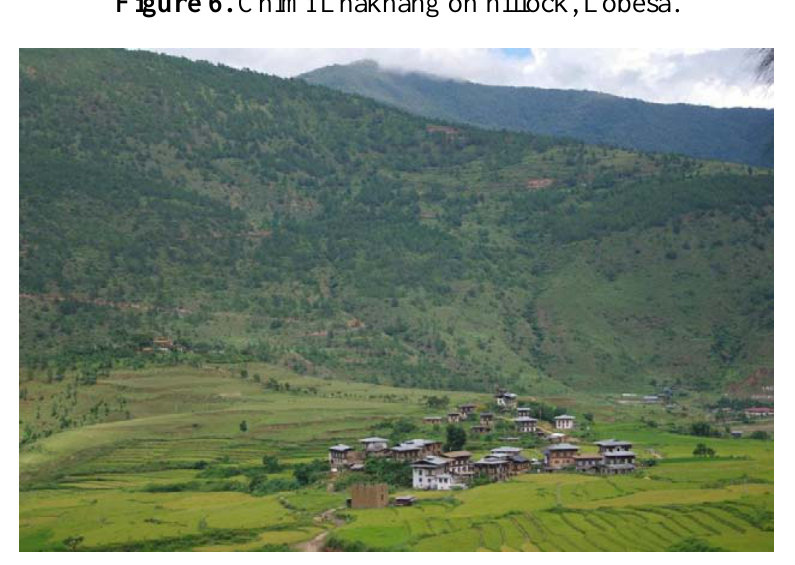
Figure 6. Chimi Lhakhang on hillock, Lobesa.